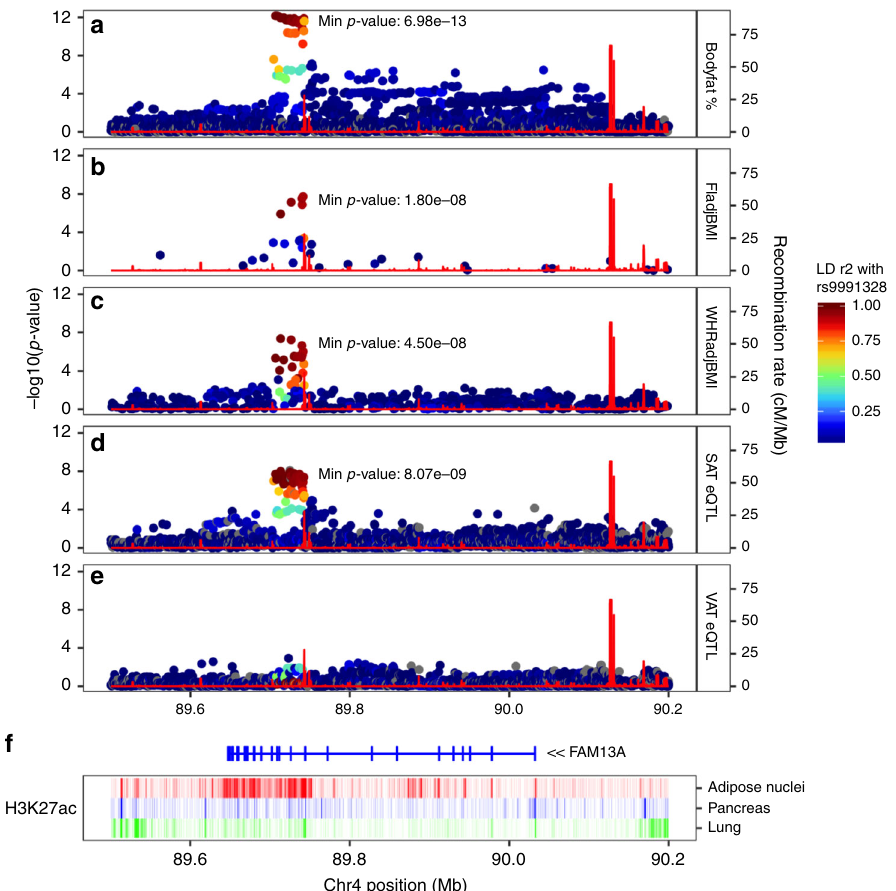
Fig. 1 Regulatory variants within the FAM13A locus are associated with several IR traits. Intronic non-coding variants in the FAM13A locus show associations with several IR-related and metabolic traits, including body fat percentage ( a ), and fasting insulin ( b ) and waist-hip ratio ( c ) (adjusted for BMI) across cohorts and studies. These GWAS association signals colocalize with FAM13A eQTL association signal in subcutaneous adipose tissue (from GTEx v7, d ). However, this association is not robust in visceral adipose tissue ( e ). f The variants show evidence of enrichment in a regulatory active H3K27ac region in adipose nuclei. Annotations from pancreas and lung are shown as negative